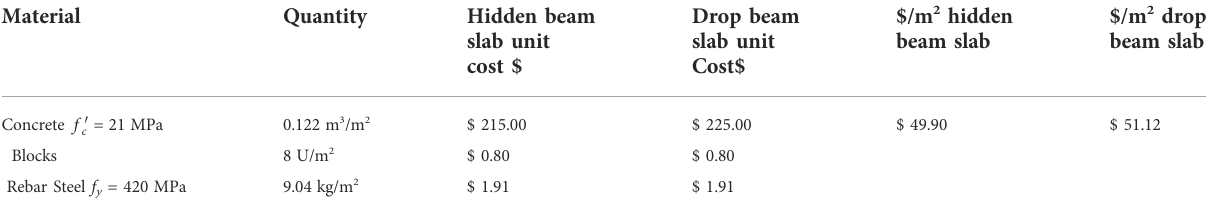
TABLE 3 Material costs for slab (Currency: US dollar). Material